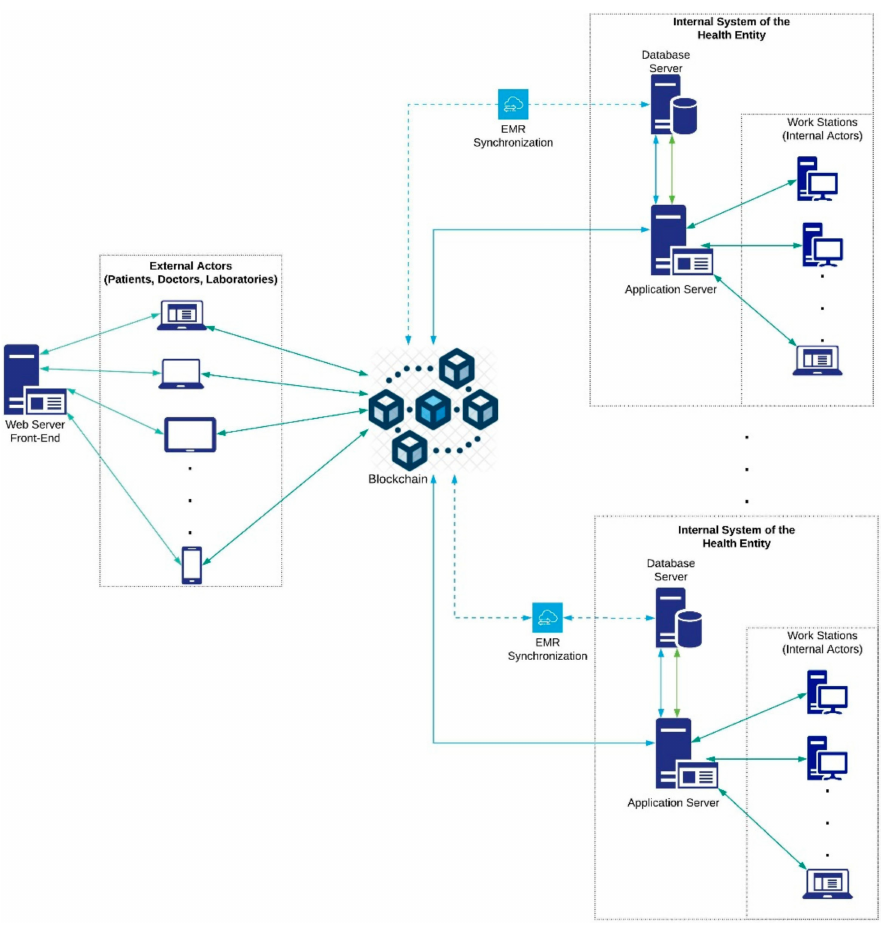
Figure 2. Architecture